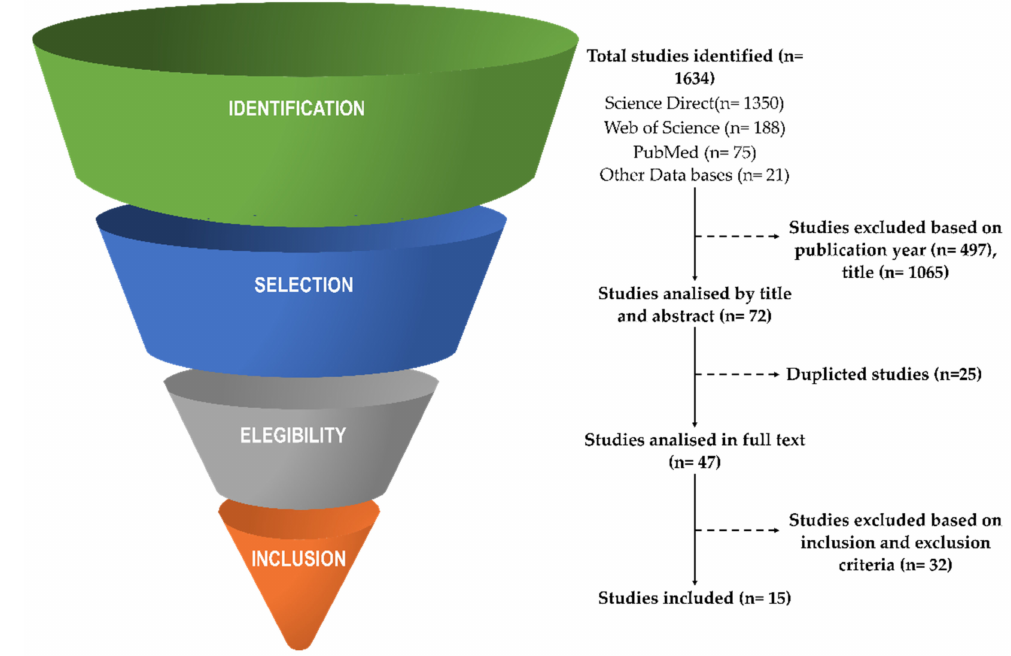
Figure 1. Flowchart of the identification, selection, and discrimination of